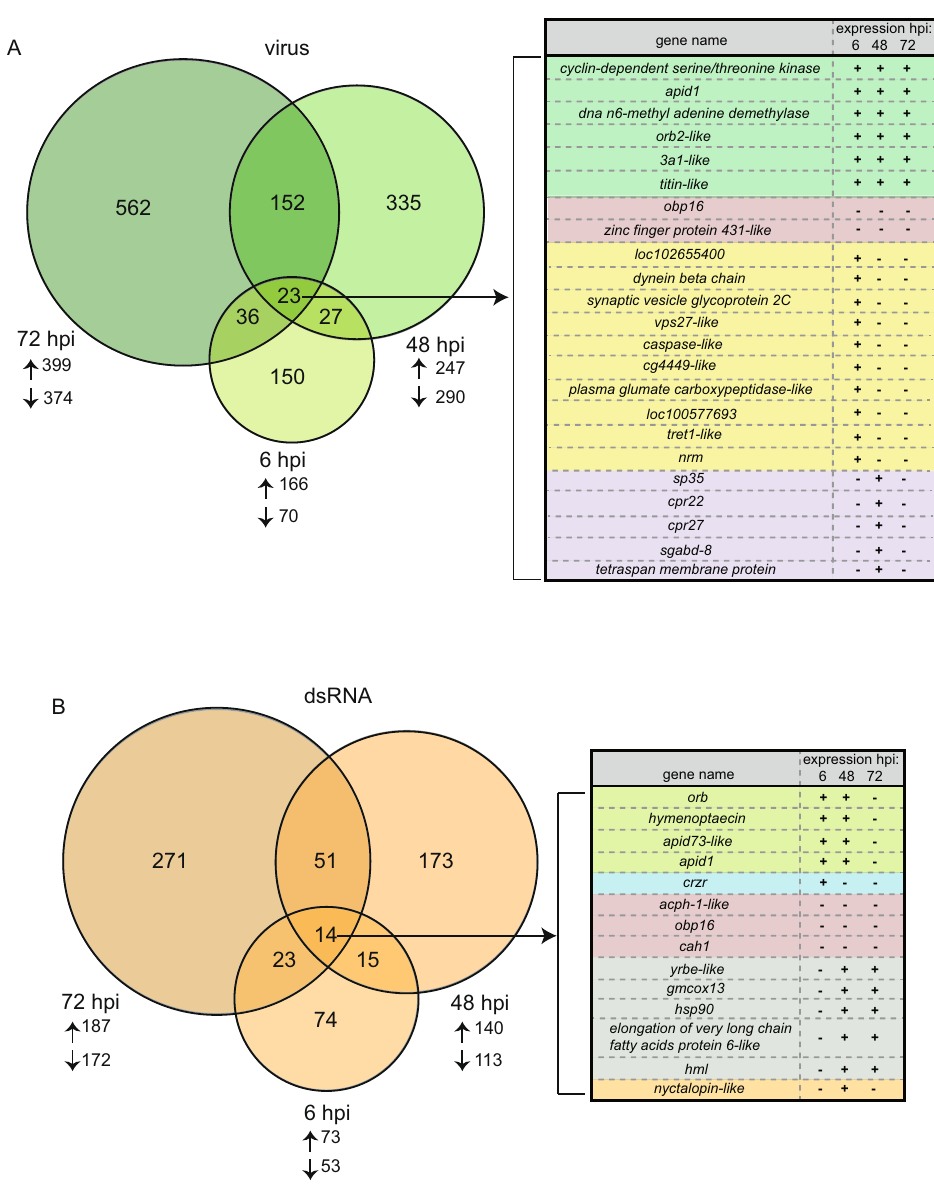
Figure 3. Honey bee transcriptional response to virus-infection and dsRNA-treatment is time-dependent. ( A ) There were hundreds of differentially expressed genes (DEGs) in virus-infected bees, as compared to mock-infected bees. Venn diagram analysis identified shared and unique DEGs of virus-infected bees 6, 48, and 72 hours post-infection (hpi). Twenty-three genes were differentially expressed at all three time points post-infection. Six of these genes consistently exhibited increased expression (highlighted in green and listed from highest average log 2 fold change to lowest) and two genes consistently exhibited decreased expression (red). Ten genes exhibited increased expression at 6 hpi and decreased expression at 48 and 72 hpi (yellow). Five genes (purple) displayed increased expression at 48 hpi, but decreased expression at 6 and 72 hpi. Arrows pointing up denote number of genes that exhibited increased expression for each time point and arrows pointing down denote number of genes that exhibited decreased expression. ( B ) There were hundreds of differentially expressed genes (DEGs) in dsRNA-treated bees compared to mock-infected bees. Venn diagram analysis identified shared and unique DEGs of dsRNA-treated bees at 6, 48, and 72 hpi, including 14 genes that were differentially expressed at all time points. There were four genes (green) that exhibited increased expression at 6 and 48 hpi and decreased expression at 72 hpi, three of which are antimicrobial peptides (AMPs). One gene, crzr , exhibited increased expression at 6 hpi, but decreased expression in bees 48 and 72 hpi (blue). Three genes displayed consistently decreased expression (red). Five genes had decreased expression at 6 hpi and increased expression at 48 and 72 hpi (gray), including heat shock protein 90 . One gene, nyctalopin - like , exhibited decreased expression in bees 6 and 72 hpi, but increased expression in bees 48 hpi (orange). DEGs with Benjamini-Hochberg corrected q-values ≤ 0.05 were included in Venn diagram analyses. Full lists of DEGs and their fold changes from all contrasts in each Venn diagram are provided in Supplementary Tables S7 and